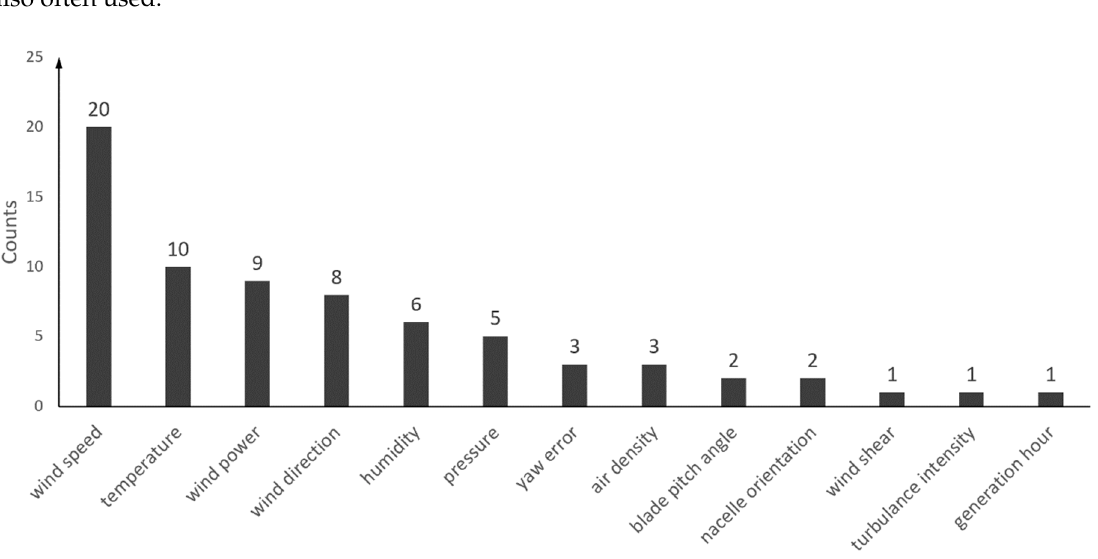
Figure 4. Statistics of used input features in the reviewed literature.